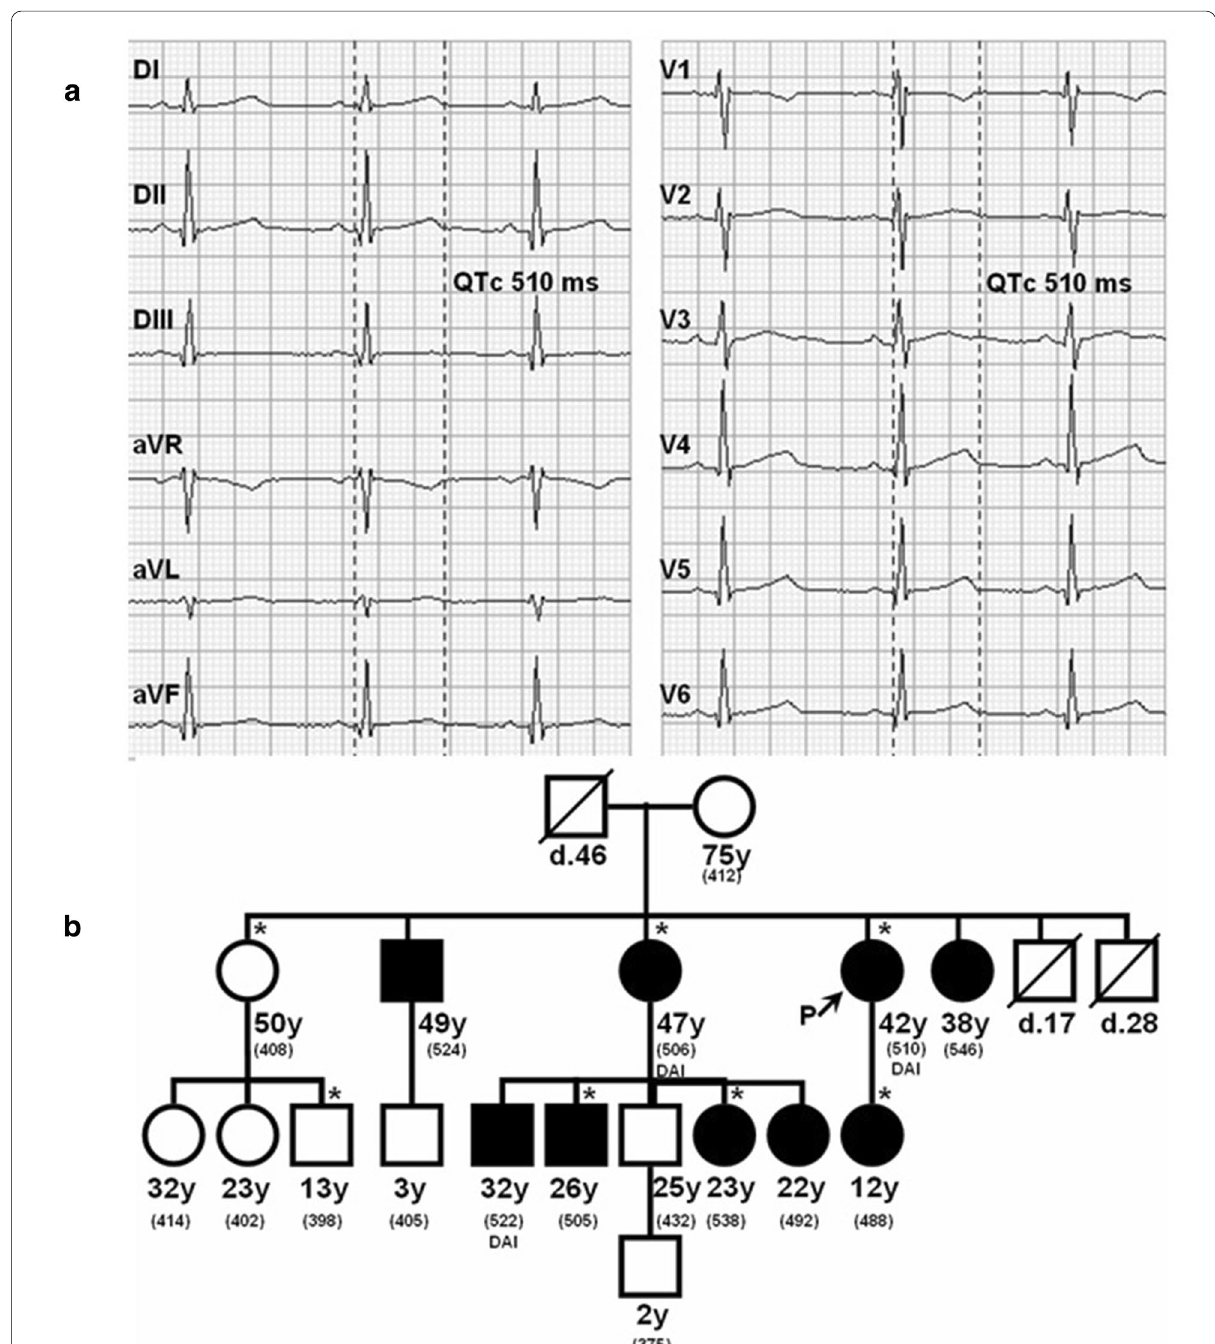
Fig. 1 a The ECG of proband. The QTc interval was prolonged: 510 ms. b Family pedigree. Seventeen individuals with their respective ages and QTc interval values (between parentheses). Squares depict male subjects; circle, female subject; open symbols, unaffected members; and solid symbol, affected member. Arrow (P) denotes proband. Her father and 2 brothers died suddenly at a young age (cross). Three family members had recurrent syncope refractory to beta-blockers and/or non-sustained ventricular tachycardia requiring an implantable cardiac defibrillator (ICD). The genetic study was carried out on 7 family members (asterisk). The novel pathogenic variant was detected in five of them that manifested the LQTS